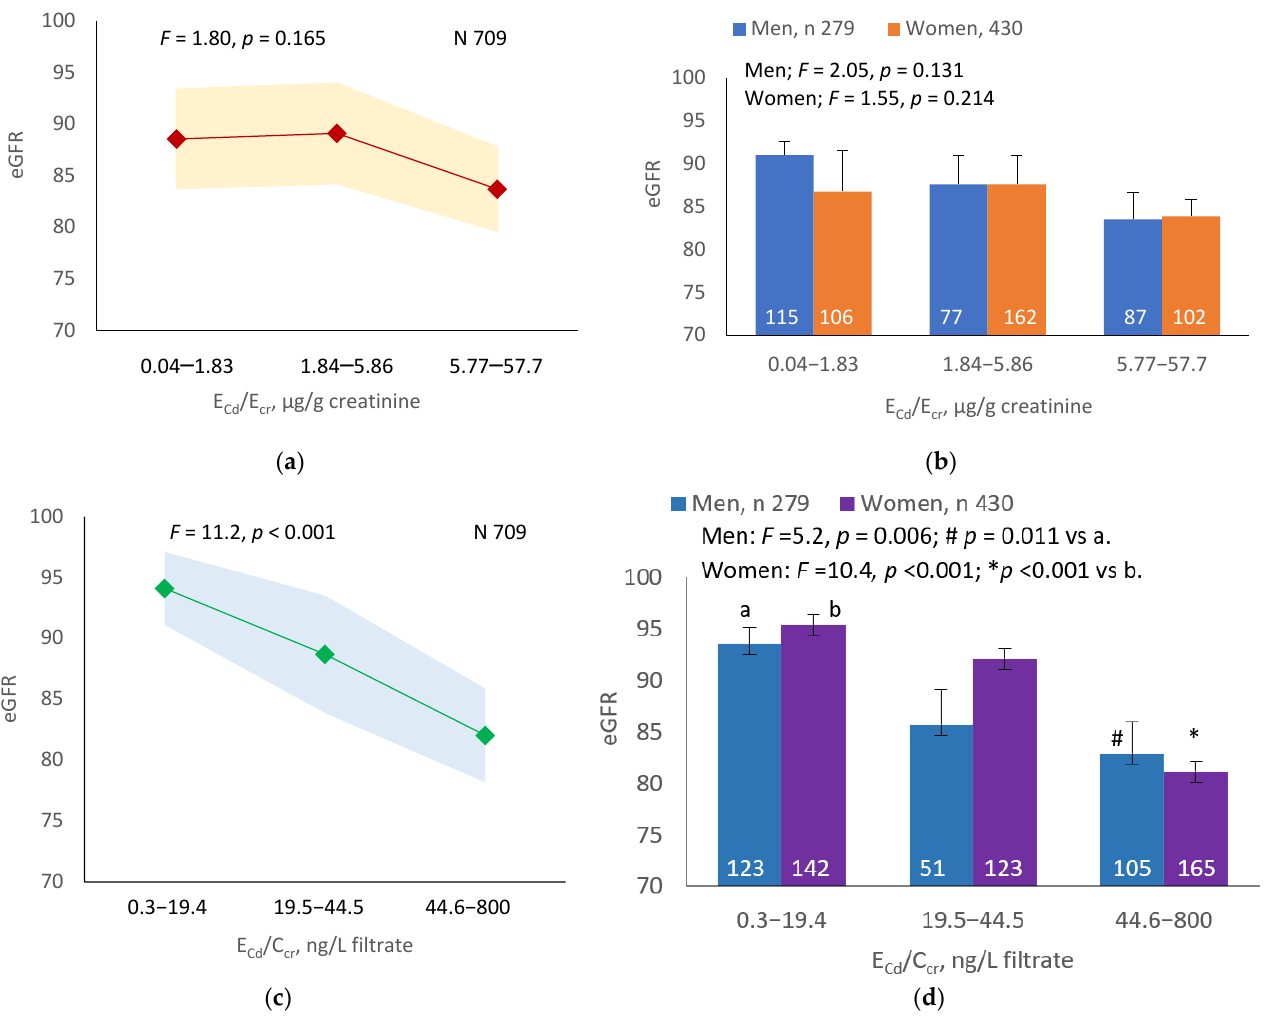
Figure 1. Cadmium-dose-dependent reductions in eGFR. The color-coded area graphs depict eGFR means with variances in subjects with E Cd /E cr Levels 1, 2 and 3 ( a ) and in subjects with E Cd /C cr Levels 1, 2 and 3 ( c ). The bar graphs show the eGFR means in men and women with E Cd /E cr Levels 1, 2 and 3 ( b ) and the eGFR means in men and women with E Cd /C cr Levels 1, 2 and 3 ( d ). Where appropriate, statistical comparisons are made within each sex between eGFR means in bars a and b. The GM (SD) values of E Cd /E cr at Levels 1, 2 and 3 are 0.51 (0.50), 3.43 (1.10), and 0.94 (7.33) µg/g creatinine, with the corresponding number of subjects being 221, 239, and 249, respectively. The GM (SD) values of E Cd /C cr at Levels 1, 2 and 3 are 5.18 (5.72), 29.6 (6.73) and 97.3 (97.7) ng/L filtrate, with the corre- sponding number of subjects being 265, 174 and 270, respectively.